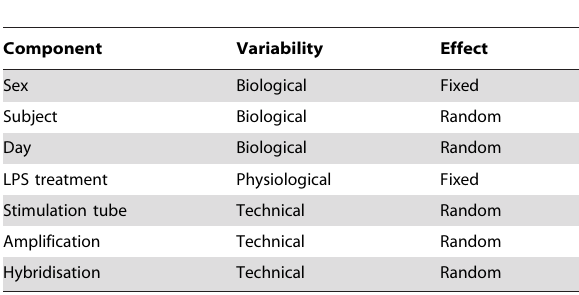
Table 1. Different components contributing to variability in the design of the